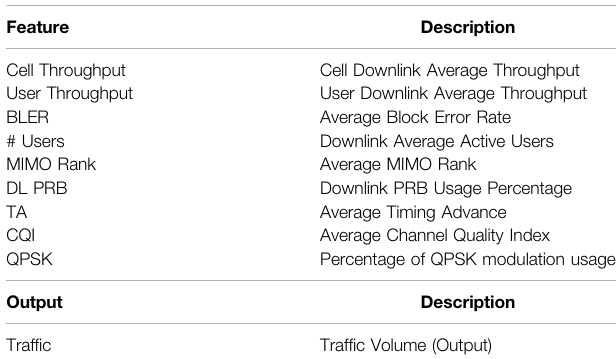
TABLE 1 | Dataset features and